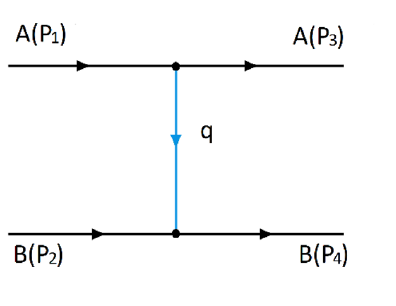
Figure 3. Tree-level diagram for the scattering of particles A and B in the t -channel. The P i denote the particle 4-momenta and the Mandelstam variable t is de(cid:12)ned by t = q 2